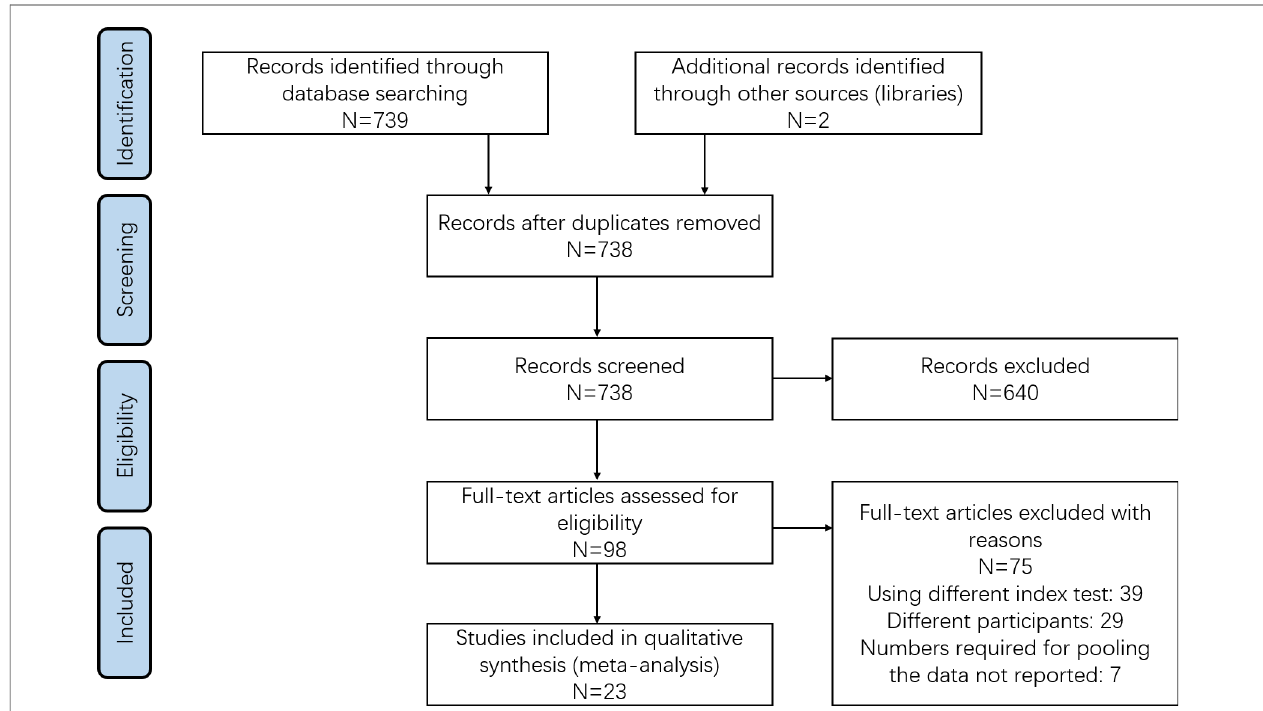
FIGURE 1 | Search strategy. Flowchart was made as per PRISMA